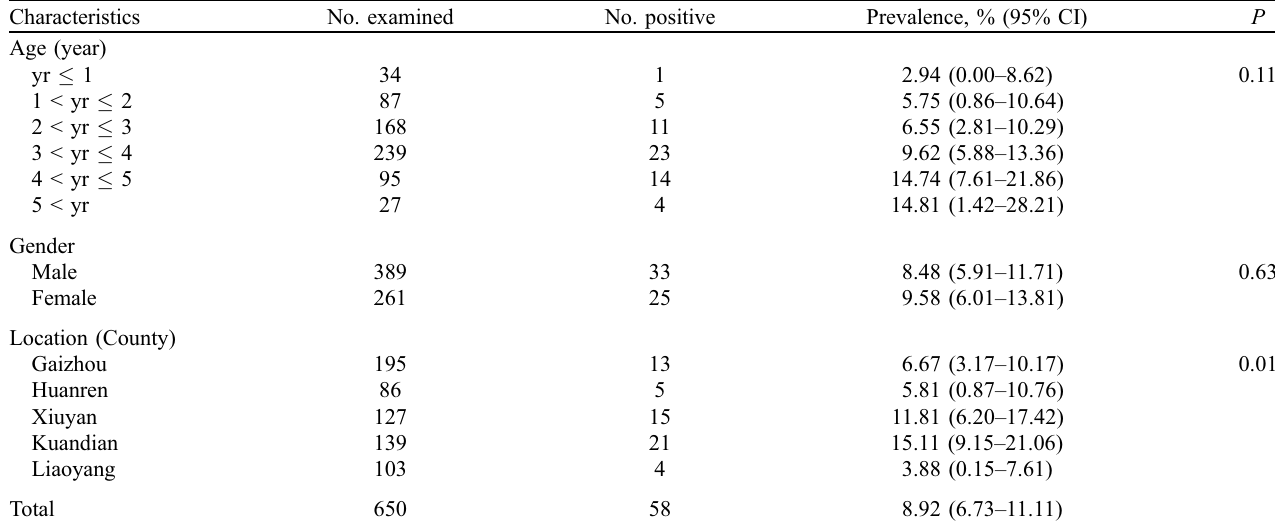
Table 1. General characteristics of the 650 goats studied and seroprevalence of T. gondii infection a in Liaoning Province, northeastern China.